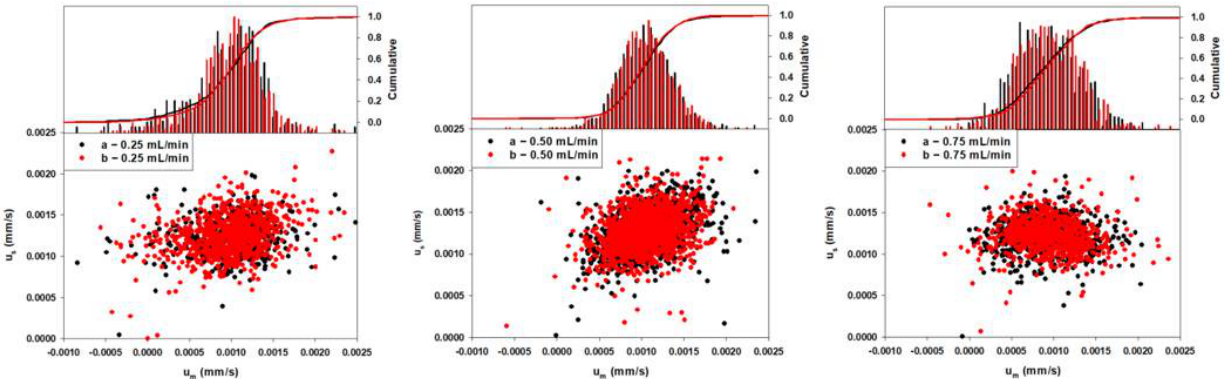
Figure 4. CTV results for the nonenriched (a, black) and enriched (b, red) streams that exit the QMS annulus for transport lamina conditions V a (cid:48) / V Tot = V a / V Tot = 0.5. After separation in the QMS, RBCs’ magnetic and sedimentation trajectories are measured in the region with constant S m . The results are shown in an offset histogram and accompanying cumulative curve. Non-parametric Mann–Whitney U-tests confirm the (a) and (b) outlets are similar for all three scatter plots.